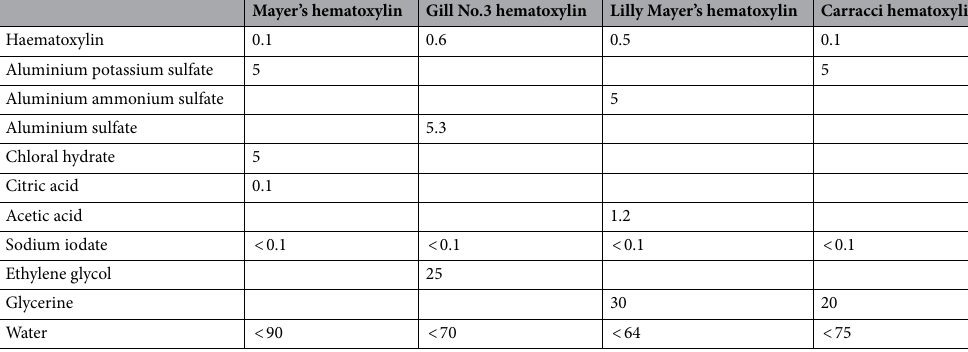
Table 1. Comparison of components of hematoxylin staining solutions (w/v